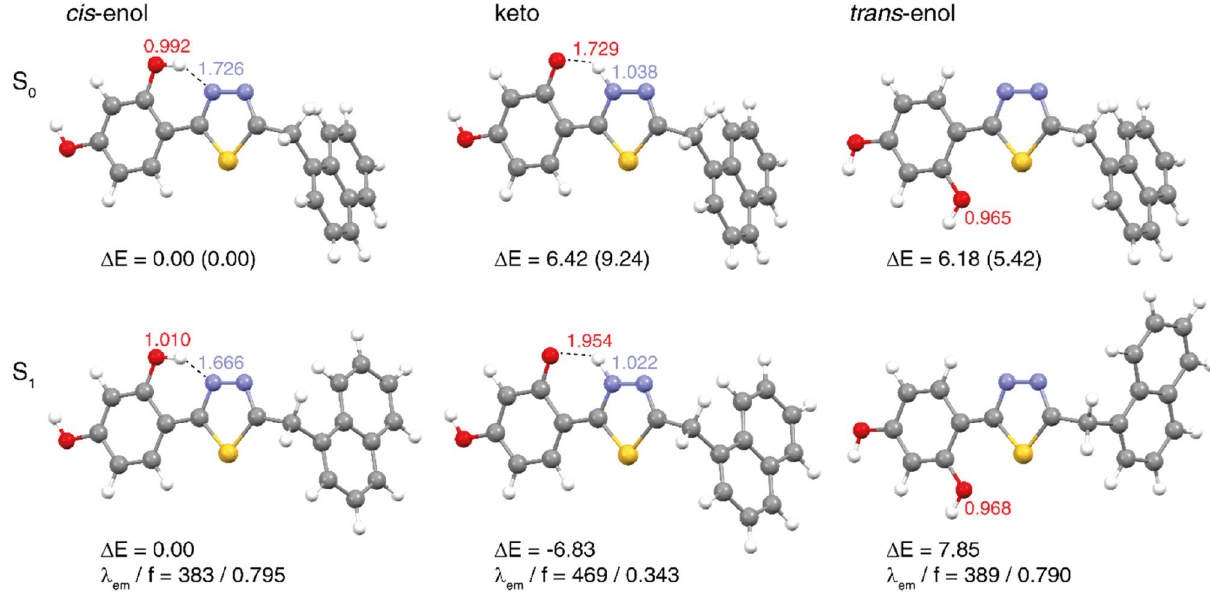
Figure 3. Optimized lowest-energy S 0 ground-state (top, based on B3LYP+D3/6–311++G(d,p)/PCM(DMSO)) and the corresponding S 1 excited-state (bottom, based on B3LYP/aug-cc-pVDZ/PCM(DMSO)) structures of enolic ( cis and trans ) and keto forms of NTBD. Values listed are the corresponding: interatomic distances d OH (in red) and d NH (in blue), in Å; relative energies Δ E computed with respect to the cis -enol structure, in kcal/ mol, in parentheses Δ E values obtained with DSDPBEP86/6–311++G(d,p)/PCM(DMSO) at B3LYP + D3/6–